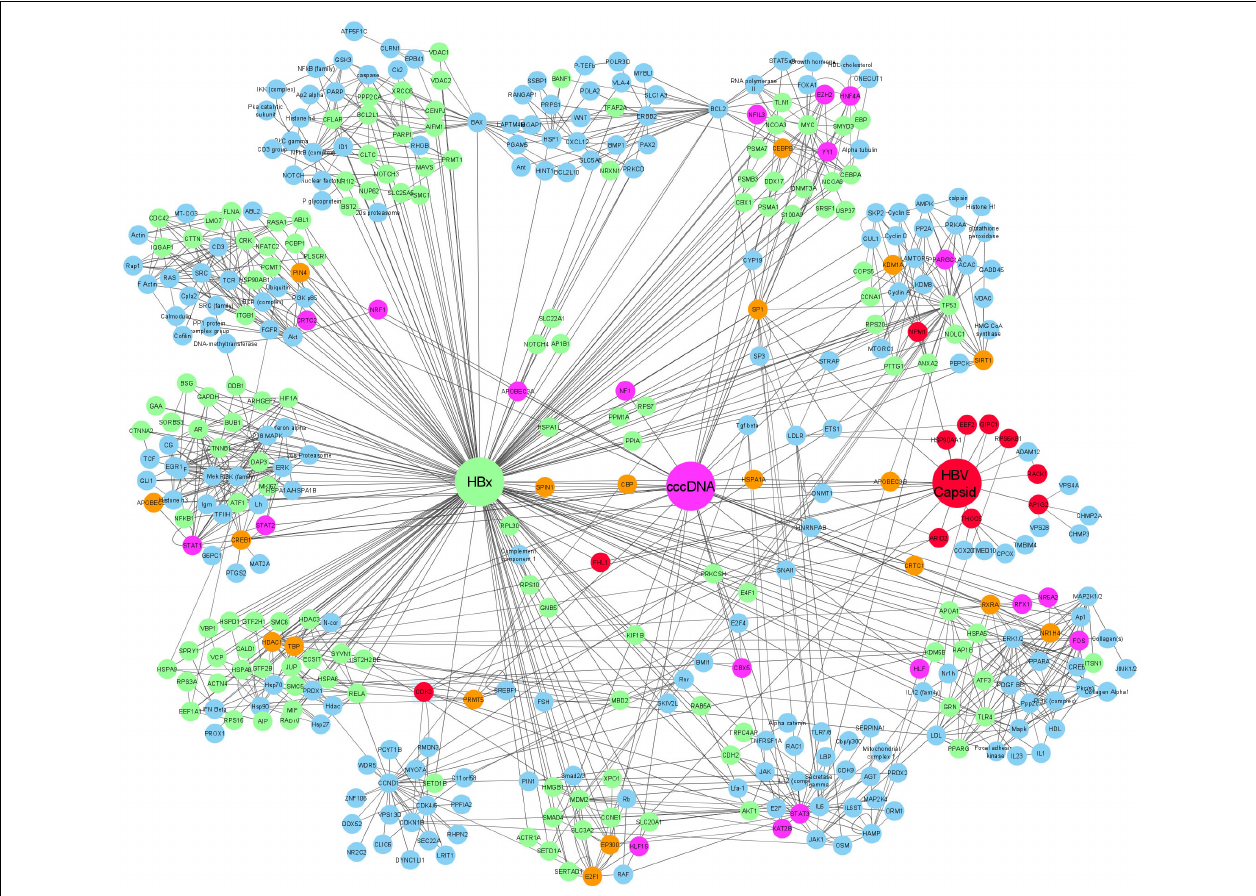
FIGURE 2 | Gene association network showing the relationship between HBx, HBc, and HBV cccDNA interacting proteins. In the network, proteins which only interact with HBx are indicated in green, proteins which only interact with cccDNA are shown in pink, and proteins that only interact with HBc are shown in red. Proteins that were shown to interact with more than two of the founding nodes (cccDNA, HBc, and HBx) are depicted in orange. proteins that were extrapolated to connect to one or more interacting proteins are shown in